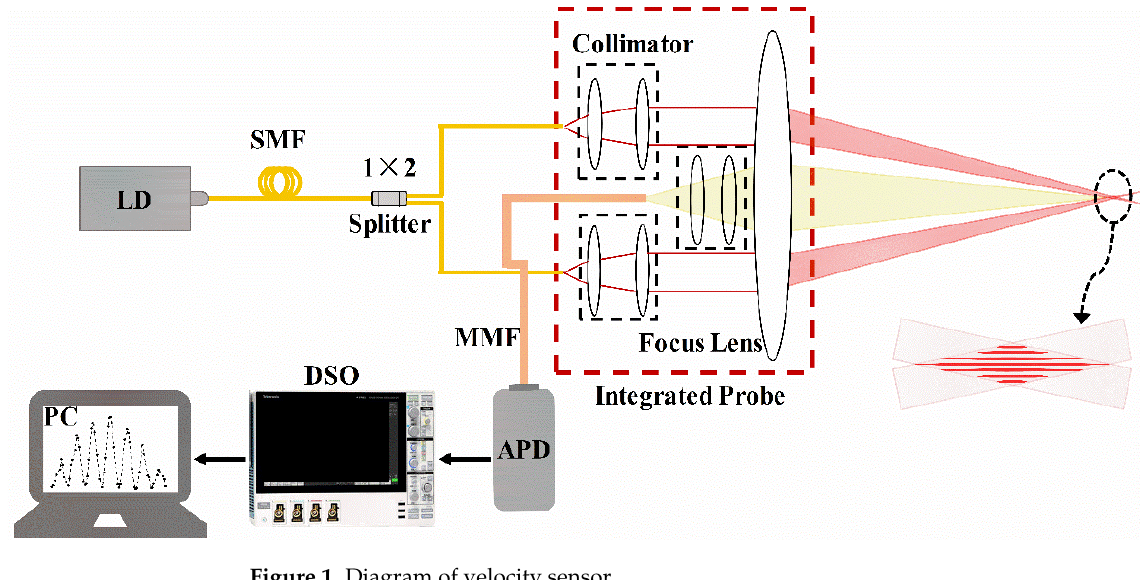
Figure 1. Diagram of velocity sensor.